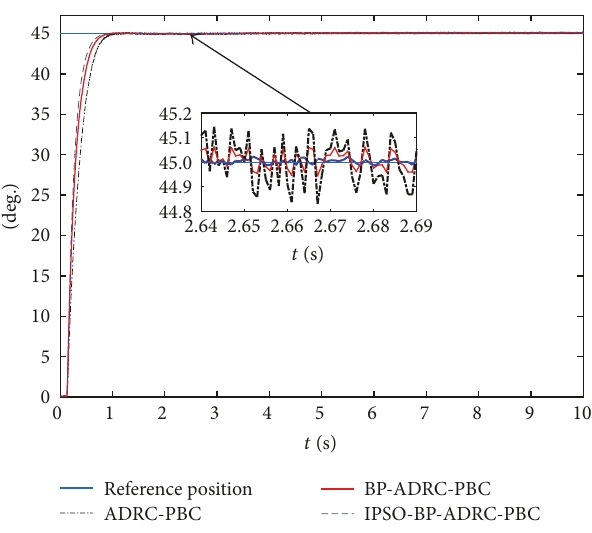
Figure 9: Step dynamic response